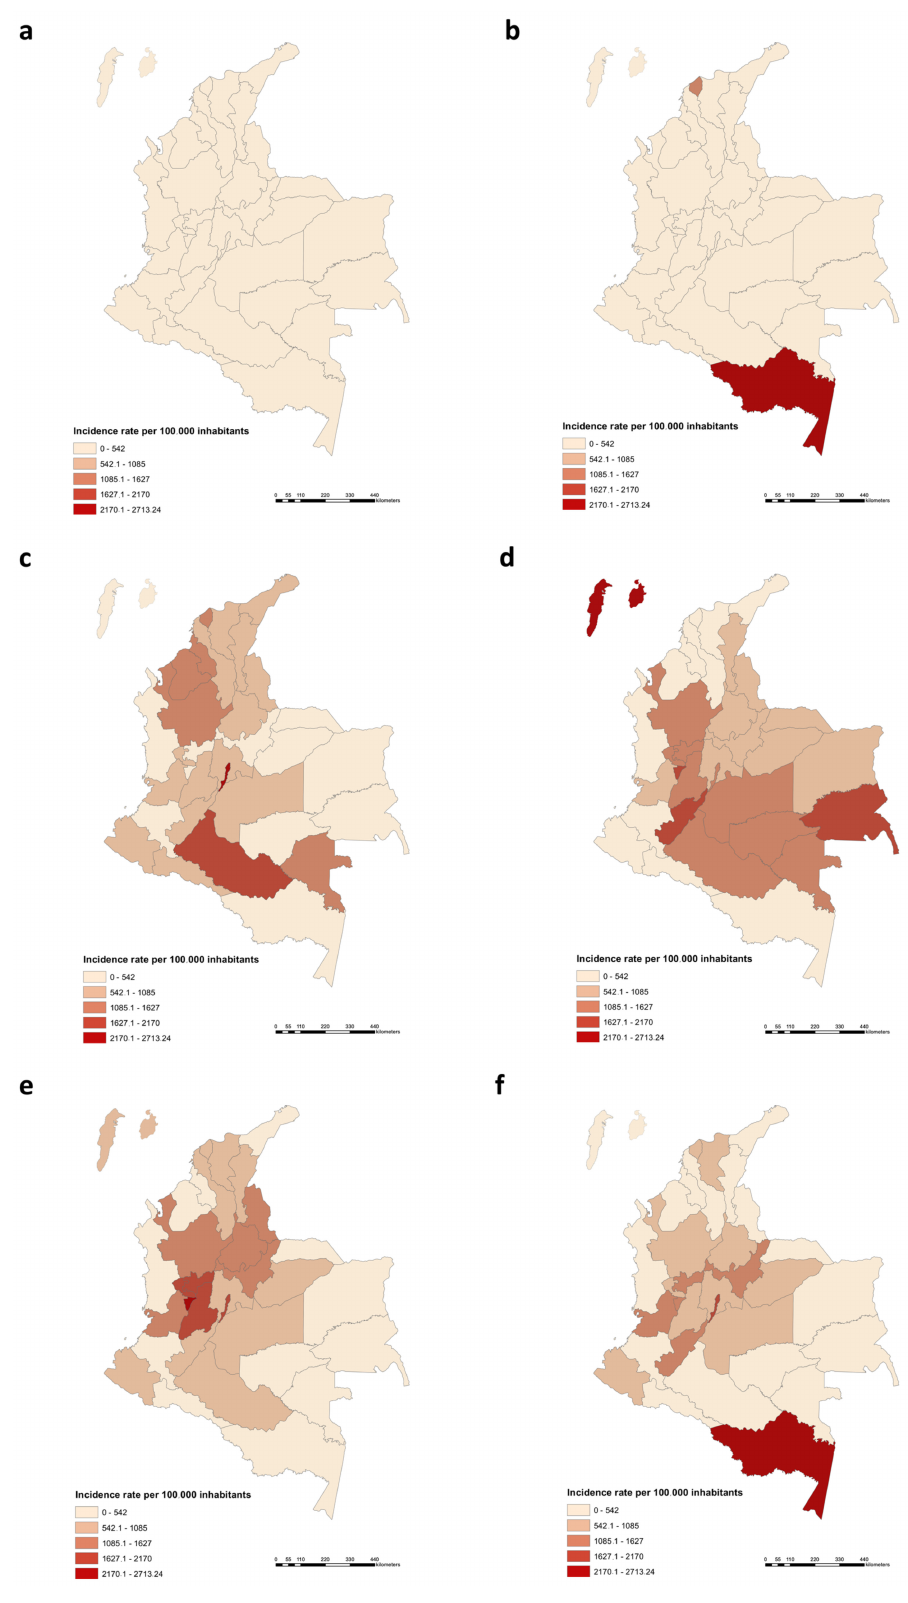
Figure 2. Geographical distribution of confirmed cases of COVID-19 in Colombia. Data was officially reported until 6 March 2021 ( n = 2,273,245). We present results of the incidence per 100,000 inhabitants; this incidence value corresponds to the color intensity in the 2-month periods ( a ) March-April, ( b ) May–June, ( c ) July–August, ( d ) September-October, ( e ) November–December and ( f ) January–February